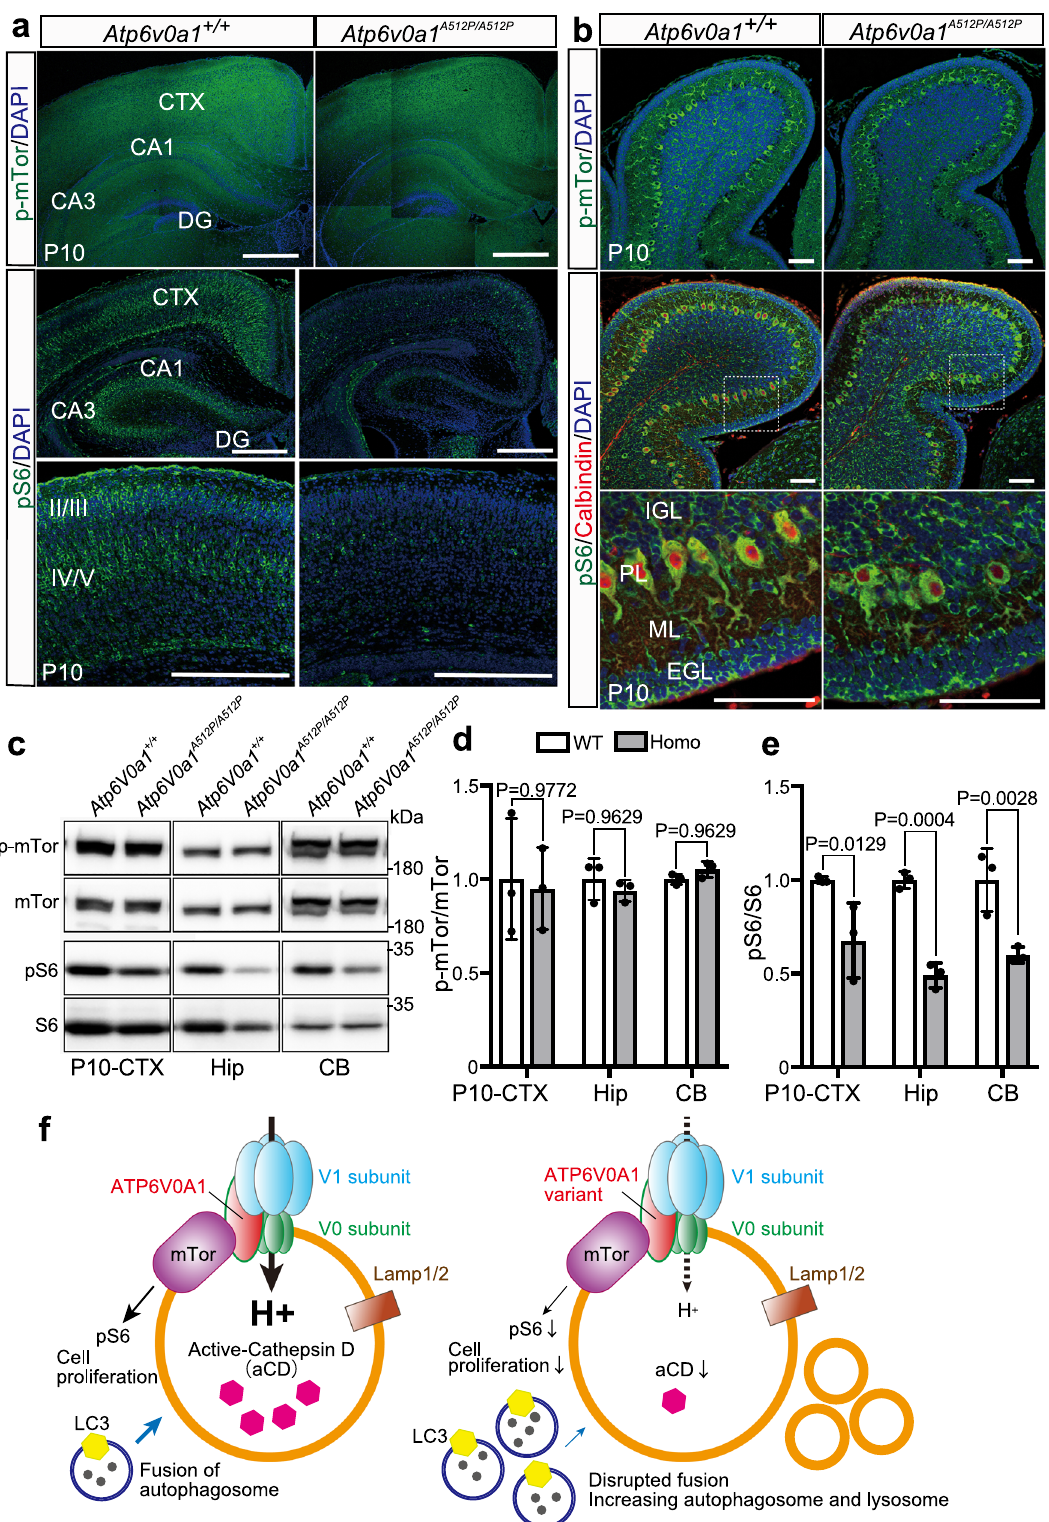
roles of the a1-subunit of the V0 domain of V-ATPase for the brain development in both humans and